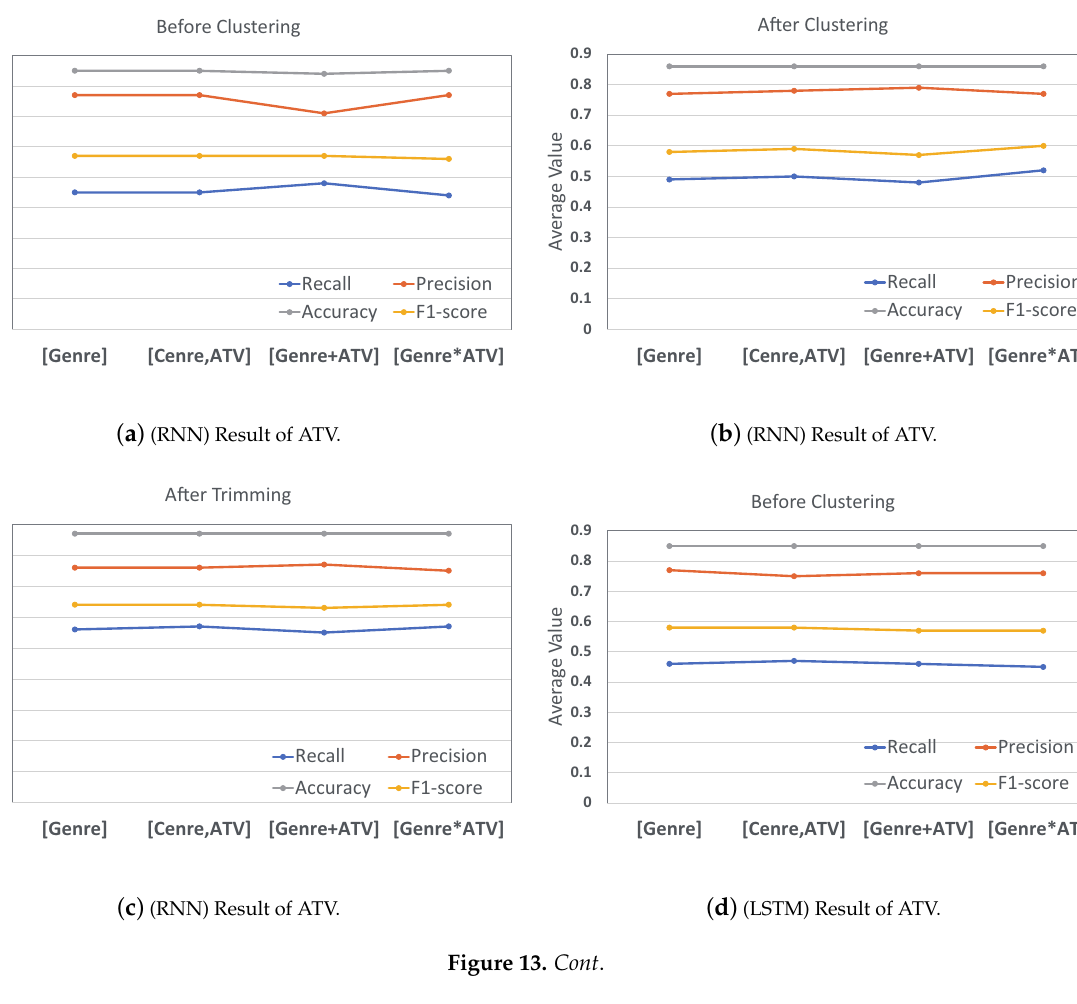
( d ) (LSTM) Result of ATV.